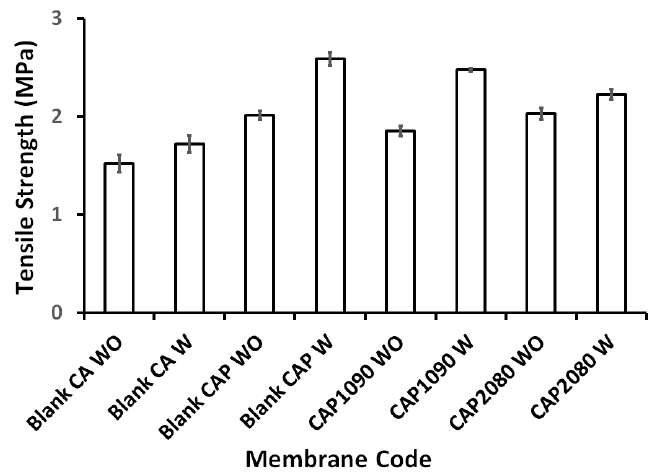
Figure 3. The effects of the added poly(methylmethacrylate) (PMMA) on the tensile strength (MPa) of the prepared blank cellulose acetate (CA) and magnetic mixed CA matrix membranes in the absence and presence of 0.1 wt.% of lithium chloride in the membrane dope.